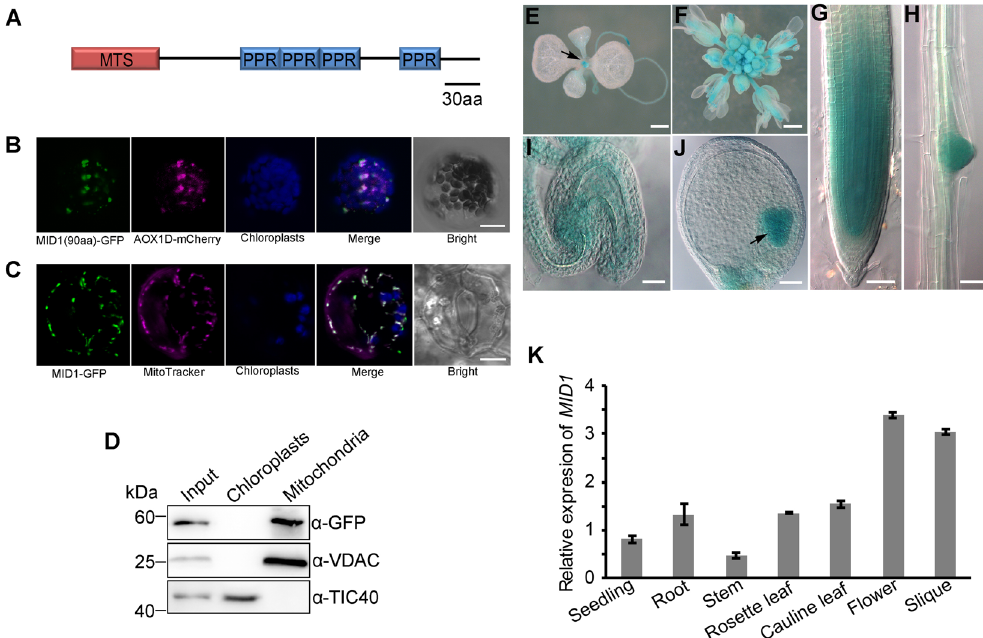
Figure 4. The subcellular localization and expression pattern of MID1. ( A ) Schematic structure of MID1. MTS, mitochondrial transient signal. ( B ) Subcellular localization of MID1-GFP in Arabidopsis protoplasts. Bar = 10 μ m. ( C ) Subcellular localization of MID1-GFP in the stomata of 35SPro : MID1 - GFP transgenic seedling. Bar = 5 μ m. ( D ) Immunodetection of MID1-GFP localization. α -VDAC and α -TIC40 are mitochondrion and chloroplast-specific antibodies, respectively. ( E – I ) The expression pattern of MID1-GUS reporter. ( E ) seedling, arrow indicates shoot apex, ( F ) flower, ( G ) root meristem, ( H ) lateral root primordium, ( I ) unfertilized ovule and ( J ) ovule with heart embryo, arrow indicate the embryo. ( E , F ) Bars = 1 mm, ( G – J ), Bars = 50 μ m. ( K ) Relative expression levels of MID1 mRNA in diverse tissues measured by qRT-PCR. The mean data are derived from triple independent biological replicates prepared from three parallel samples, and finally normalized with ACTIN2